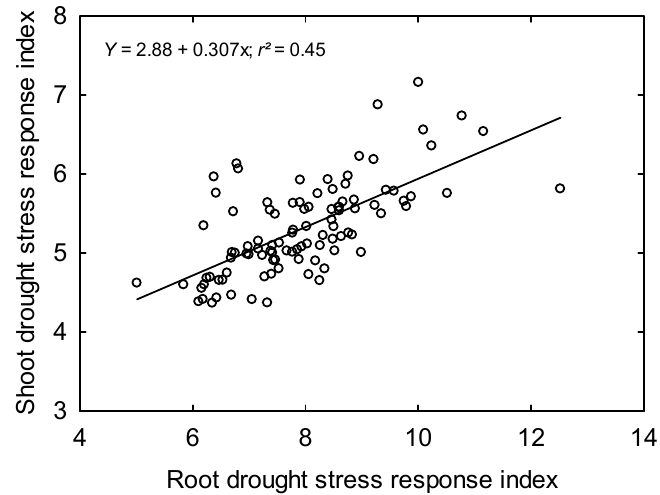
Figure 4. The relationship between cumulative drought response index and cumulative drought stress response index of root and shoot indices of 100 elite rice genotypes.